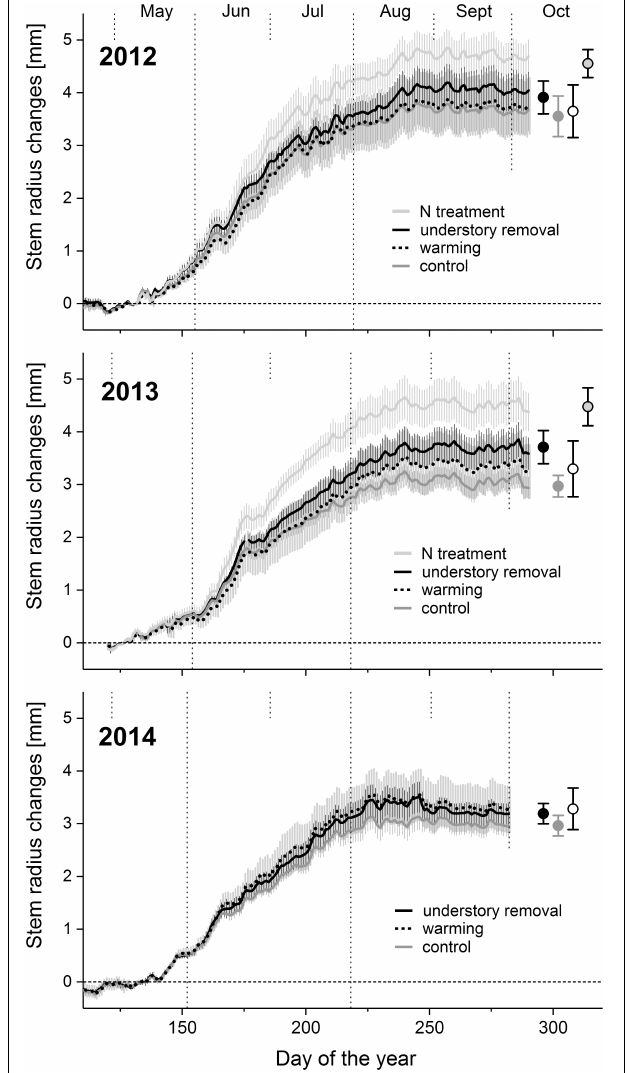
FIGURE 2 | Time series of mean daily Pinus cembra dendrometer records and standard deviations of the control, warming, understory removal and the N during growing seasons 2012, 2013, and 2014. Circles denote mean upper asymptotes ± SD of the Gompertz functions of each